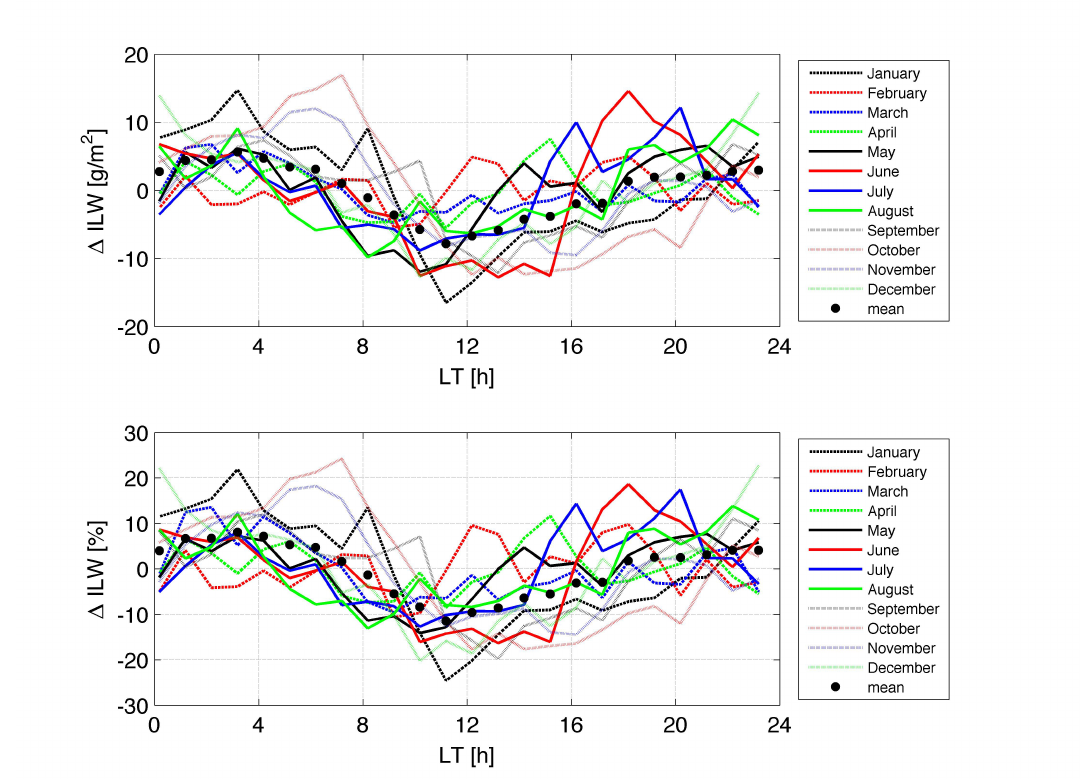
Figure 6. Seasonal dependence of the diurnal cycle in ∆ ILW as a function of local time over Bern for the time interval 2004–2016. The upper panel shows the absolute diurnal cycle ( ∆ ILW = ILW − monthly mean of ILW) while the lower panel shows the relative diurnal cycle with respect to the monthly mean and in percent. The black dots indicate the annual mean of the seasonal